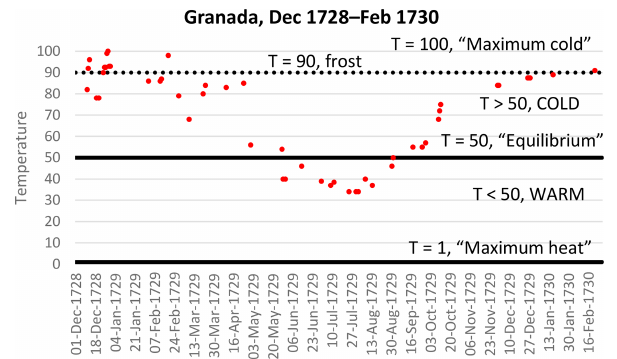
Figure 7. Monthly mean value of daily temperature in 1729 and error margins estimated and comparison with monthly mean value of daily maximum temperature (TX) and monthly mean value of daily mean temperature (TM) of 1906–1930.